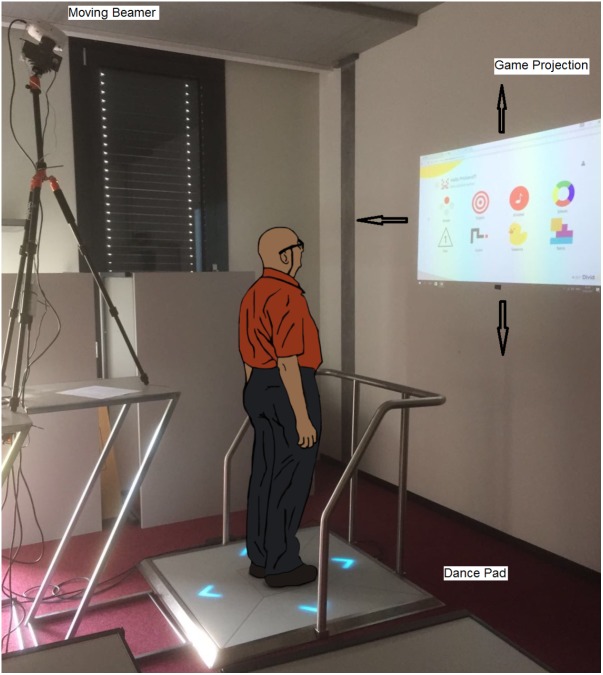
The Senso exercise system with moving beamer (arrows show motion extent of game projection).